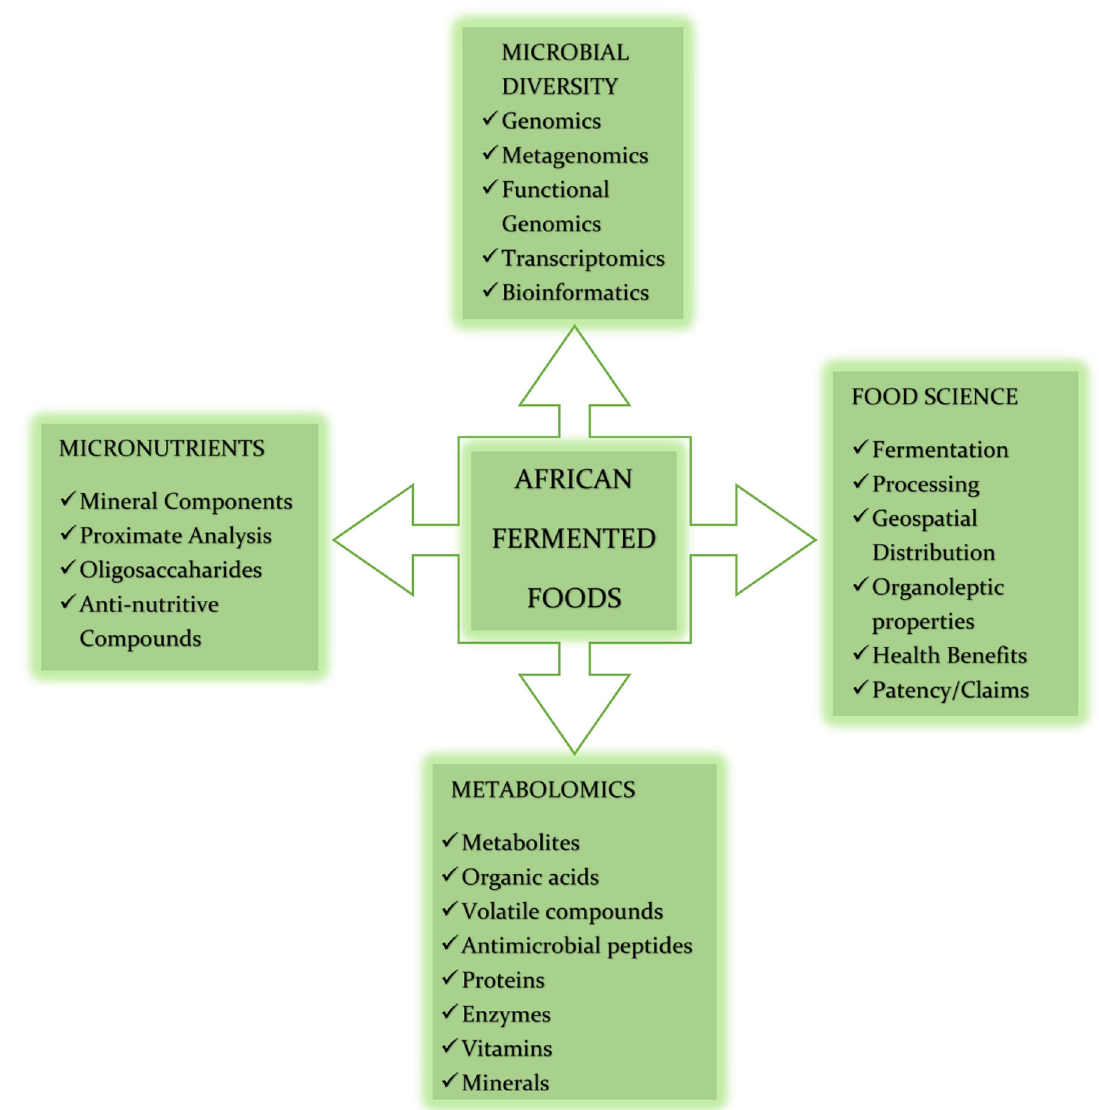
Fig. 2 Overview of potential study areas in African fermented